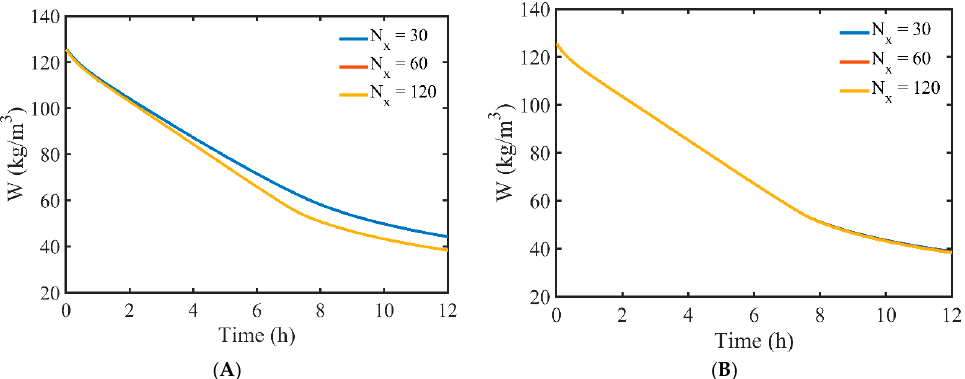
Figure 3. Temporal variations of total moisture content in the brick at 1 cm depth predicted with a ( A ) non-equilibrium and ( B ) equilibrium model for three mesh densities given with number of divisions N x .